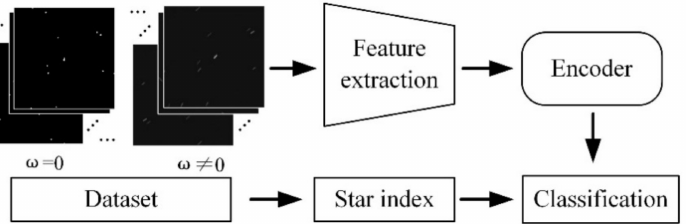
Figure 4. Process of the end-to-end star-ID algorithm. The data set of each main star is constructed by Section 2, including different sets of motion states.